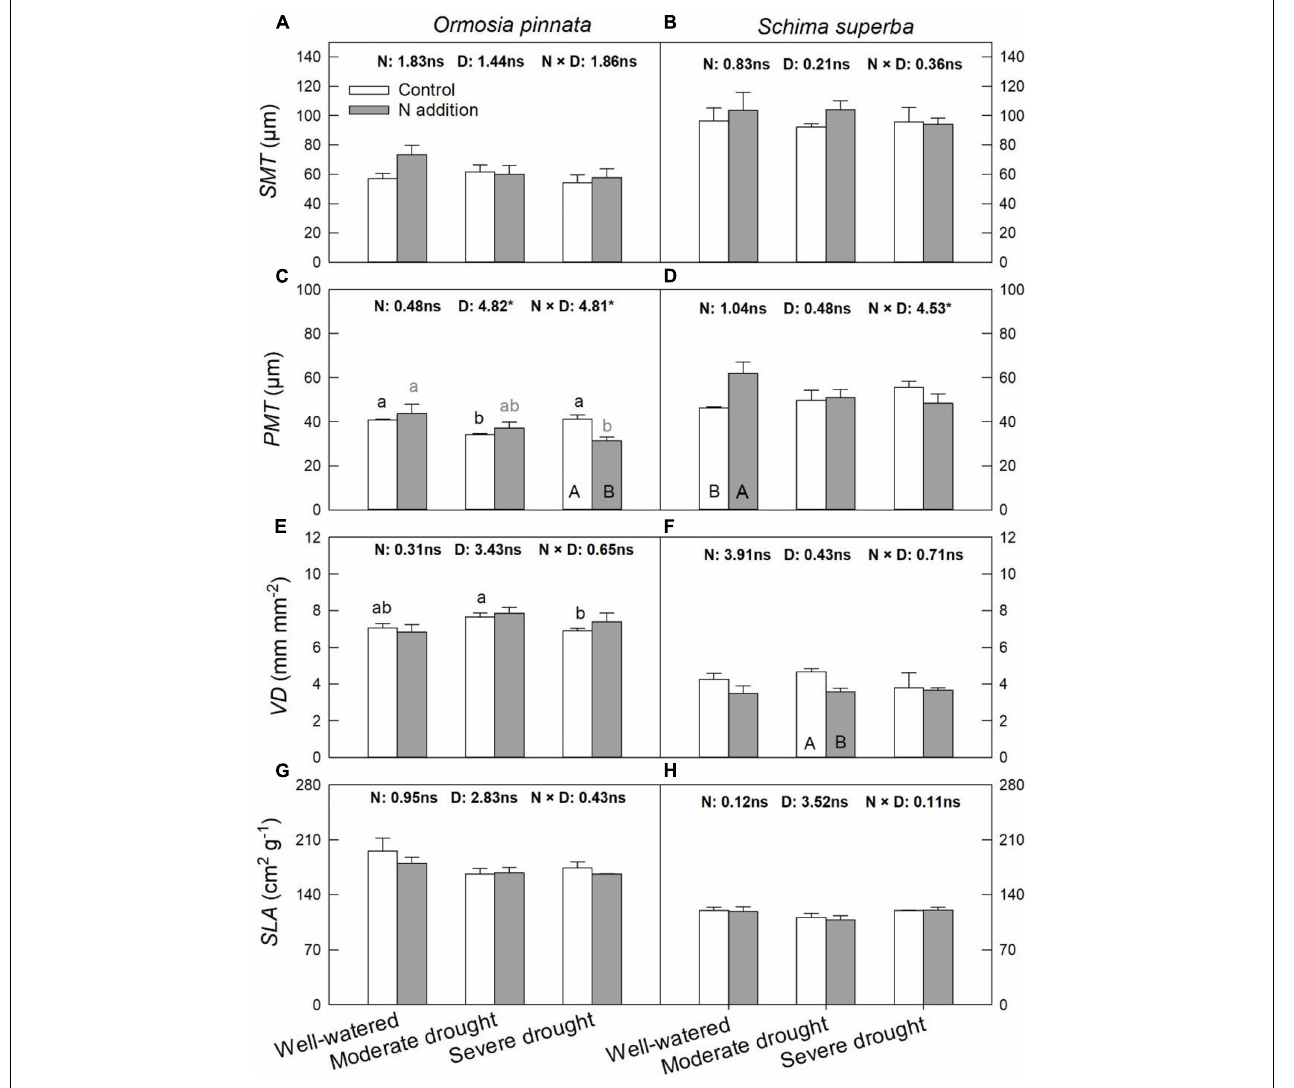
FIGURE 5 | Responses of leaf palisade mesophyll thicknesses ( PMT ; A,B ), spongy mesophyll thicknesses ( SMT ; C,D ), leaf vein density ( VD ; E,F ), and specific leaf area ( SLA ; G,H ) of O. pinnata and S. superba to different watering and N addition treatments. Bars show means ± SE ( n = 3). Different lowercase letters above bars indicate significant differences among three watering regimes within each N addition rate. Different capitalized letters below bars indicate significant differences between control and N addition within each watering regime. F -values of the two-way ANOVA of nitrogen (N), drought (D), and their interactions (N × D) are indicated. * P < 0.05; ns, not